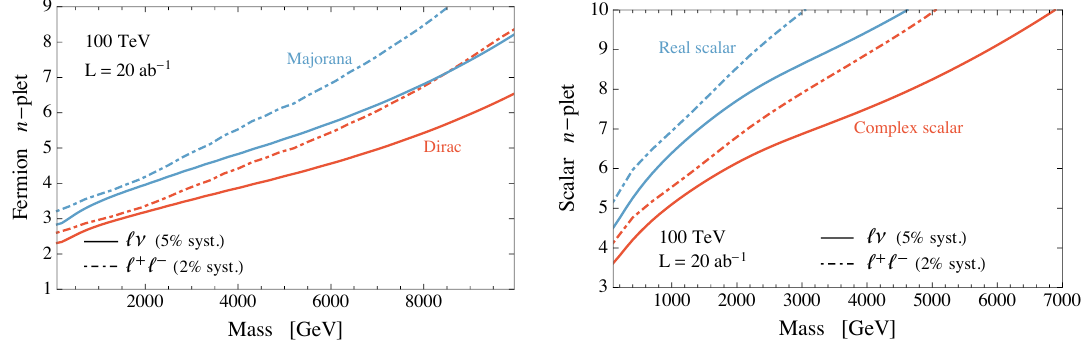
Figure 6 . Expected 95% CL exclusion limits obtained for the